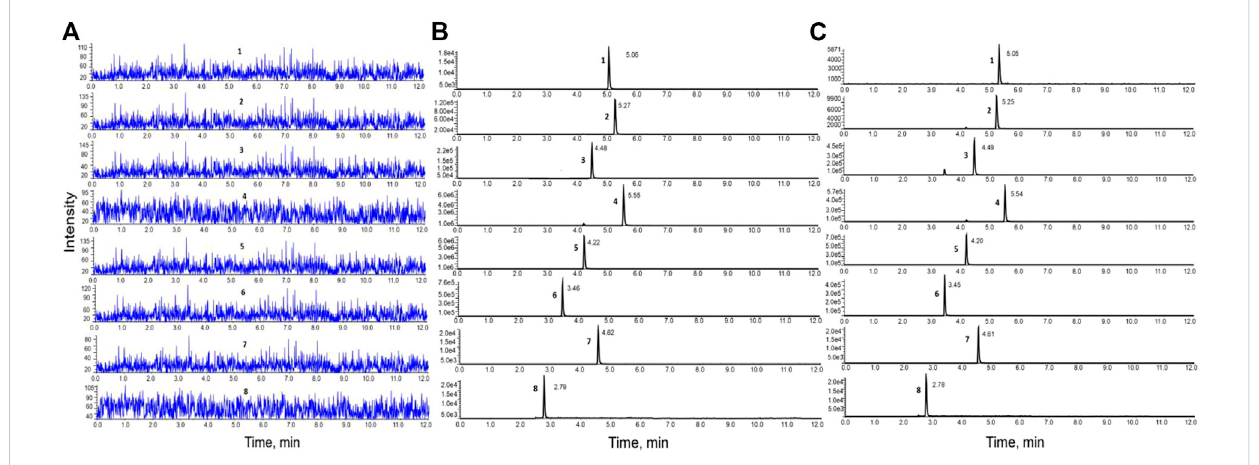
FIGURE 1 HPLC-MS/MSchromatogramsofthesixcomponents. (A) .Blankinactivatedlivermicrosomal sample; (B) .Blank inactivatedlivermicrosomalsample mixed with the six components and internal standard; (C) . Samples obtained after incubation with liver microsomes.